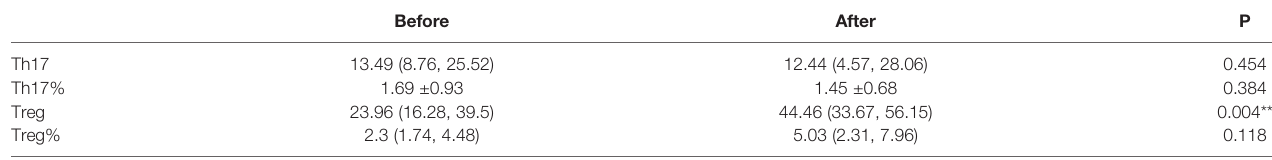
TABLE 2 | Treg cells were increased after treatment.